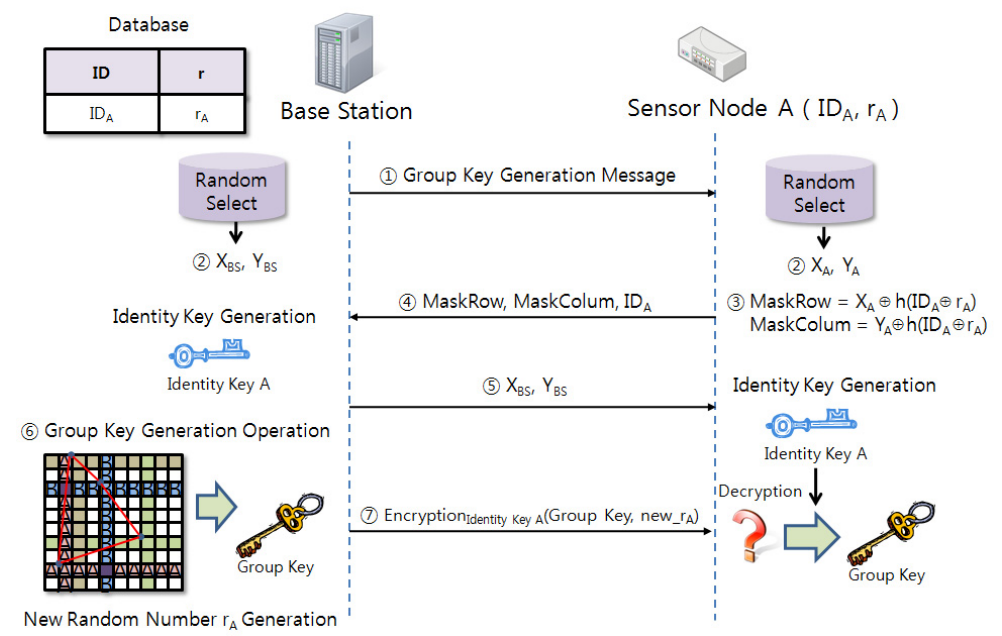
Figure 3. Group Key Agreement